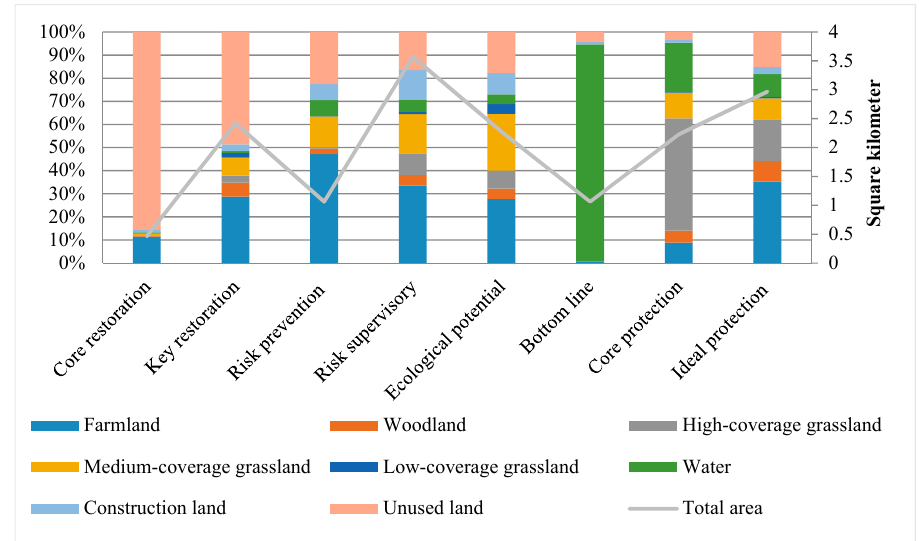
Figure 14. Space partition and land use type.